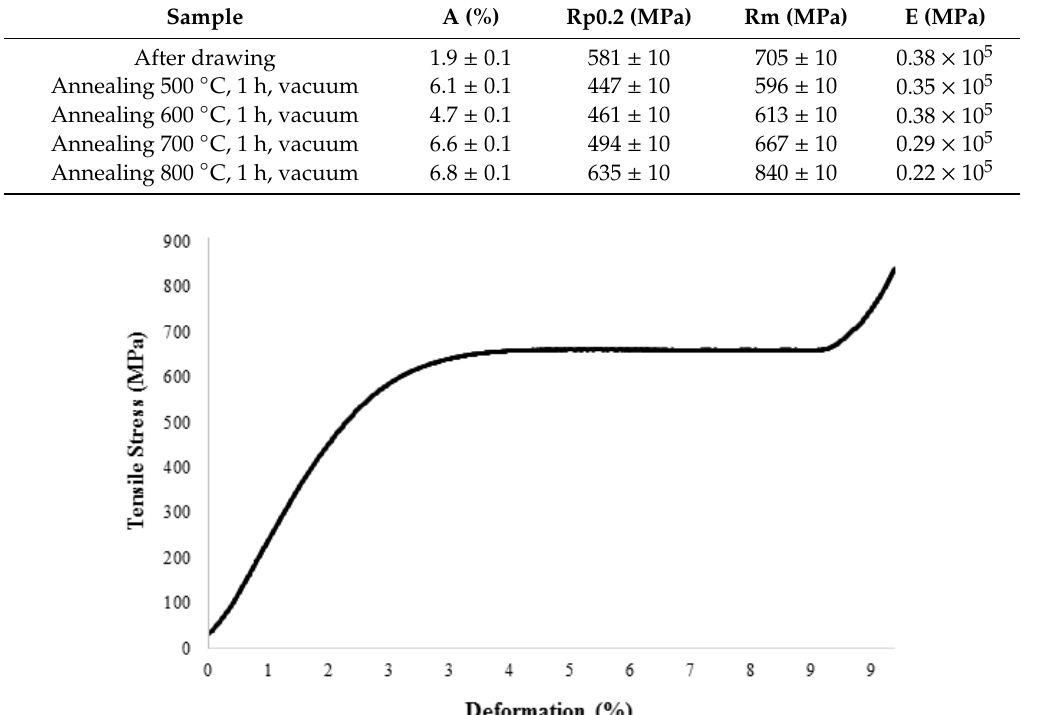
Figure 13. Results of uniaxial tensile tests of Ti–28Nb–5Zr wire after annealing at 800 °C for 1 h in vacuum.